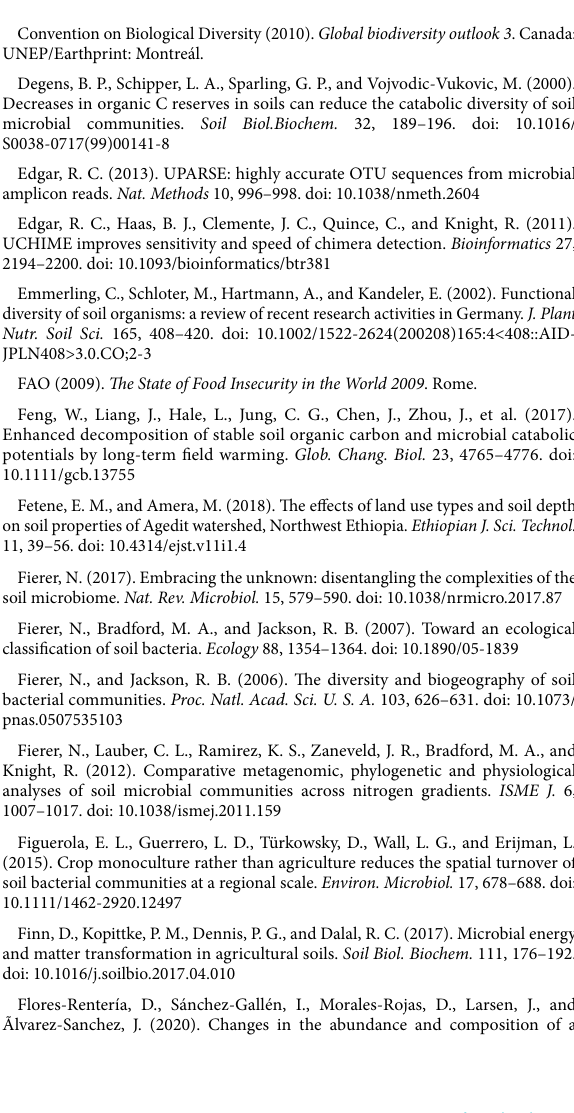
SUPPLEMENTARY FIGURE S1 Redundancy analysis (RDA) of bacterial composition and soil properties at dominant phylum, order and genus levels in soils of different land use types and dept